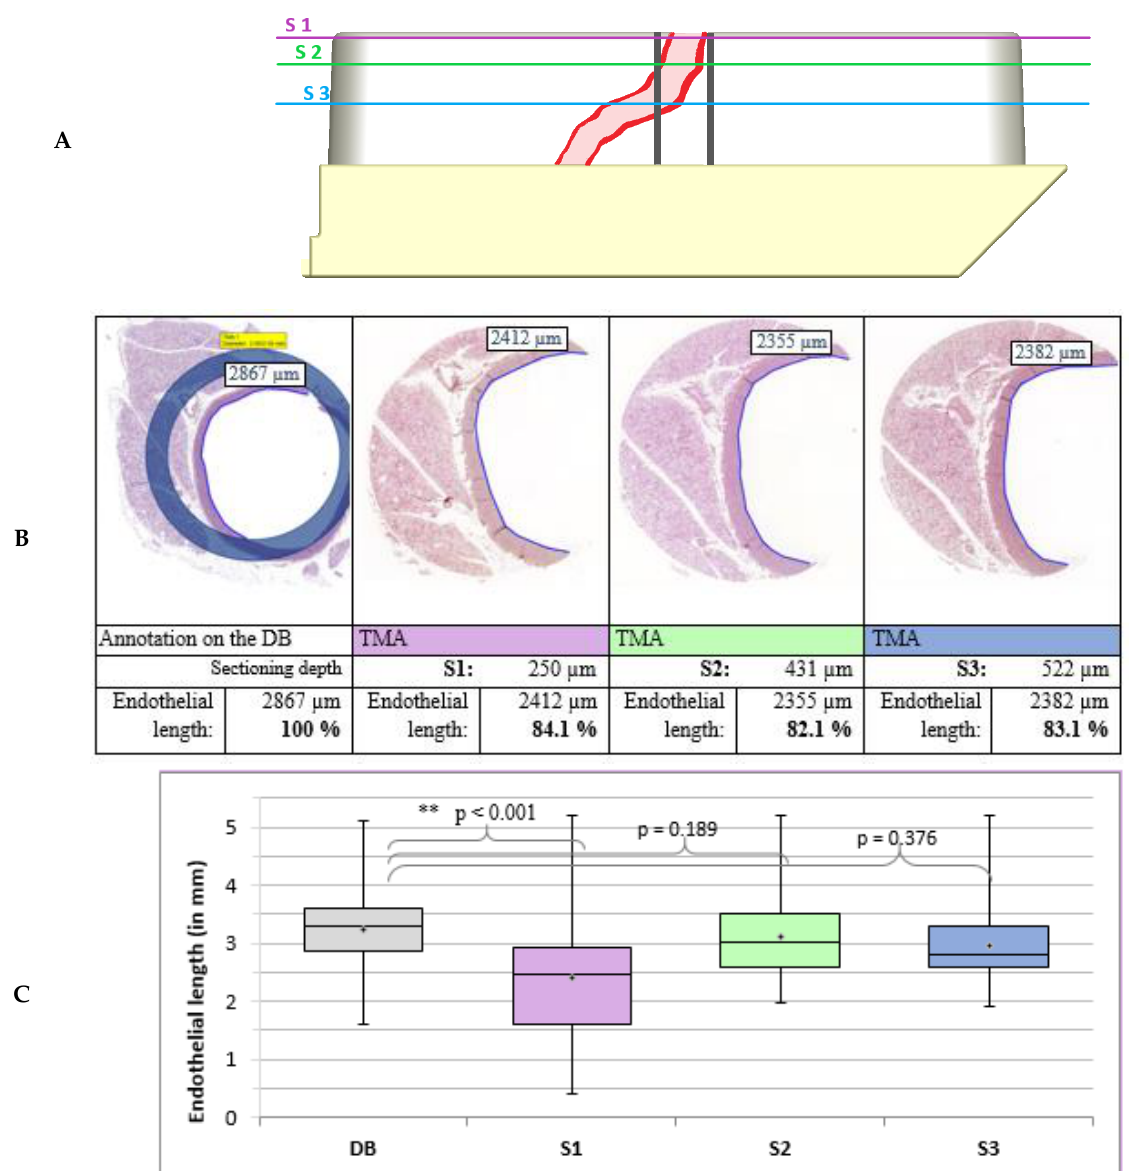
Figure 6. Comparison of the endothelial length. ( A ) Correlation between the sectioning depth (S1, S2, S3) and the accuracy of the ngTMA ® method. An exemplary target structure in a paraffin block may deviate due to sectioning depth. ( B ) The figure shows the H&E section of the donor block (DB) on the left-hand side, followed to the right side by three slides of descending sectional depth (S1, S2, S3) of the respective TMA block. The endothelial surface is marked in blue. Listed underneath each picture is: 1. the sectional plane (S1, S2, S3) and the corresponding depth in µ m, 2. the measured length in µ m and 3. the deviation percentage comparing the length of the TMA slide with the annotated H&E slide. ( C ) Distribution of the endothelial length depending on the sectional plane DB: Donor-Block ( n = 90), sectional plane: S1: n = 43; S2: n = 89; S3: n = 48. The Rhombus-Symbol ( • ) marks the arithmetic mean. There is a strong significance ( p < 0.001), indicated with **, when comparing the DB with the sectional plane S1, but no statistically significance when comparing DB to sectional planes S2 and S3. 3D sketches with kind permission of W.